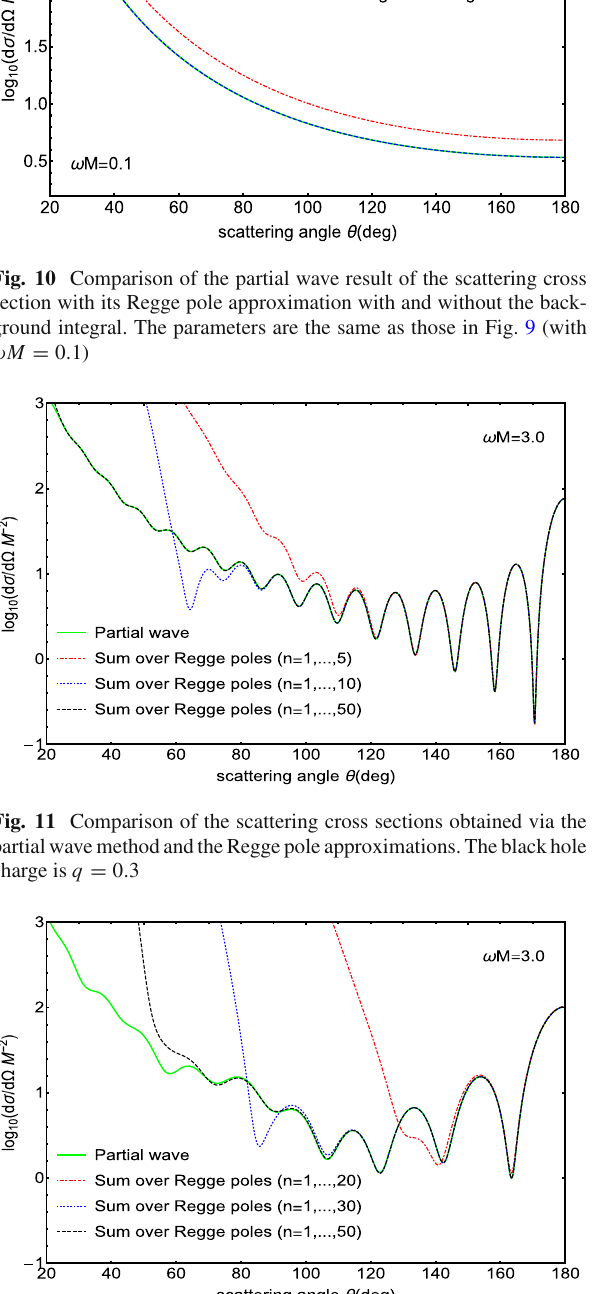
Fig. 12 Comparison of the scattering cross sections obtained via the partialwavemethodandtheReggepoleapproximations.Theblackhole charge is q = 0 . 999